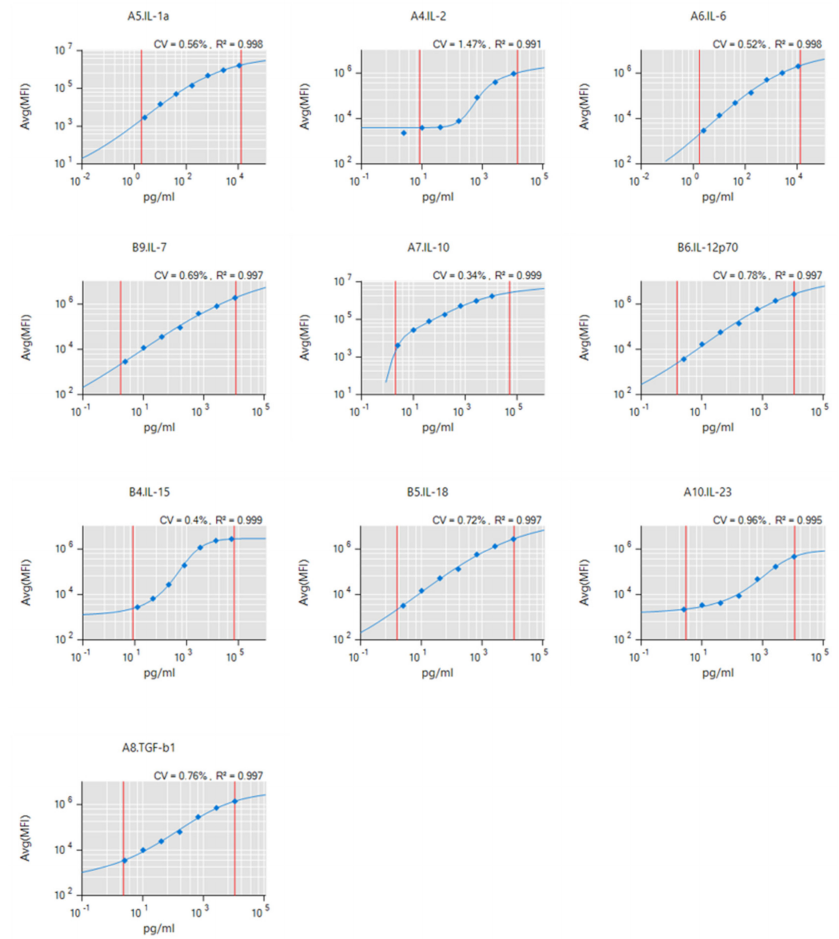
Figure A1. Standard curves from the multiplex cytokine analysis for each analyte across a range of concentrations shown together with the corresponding average mean fluorescence intensities (Avg(MFI)). All curve fittings had an R 2 of greater 0.99, providing great accuracy for the quantification of absolute cytokine levels in moDC culture